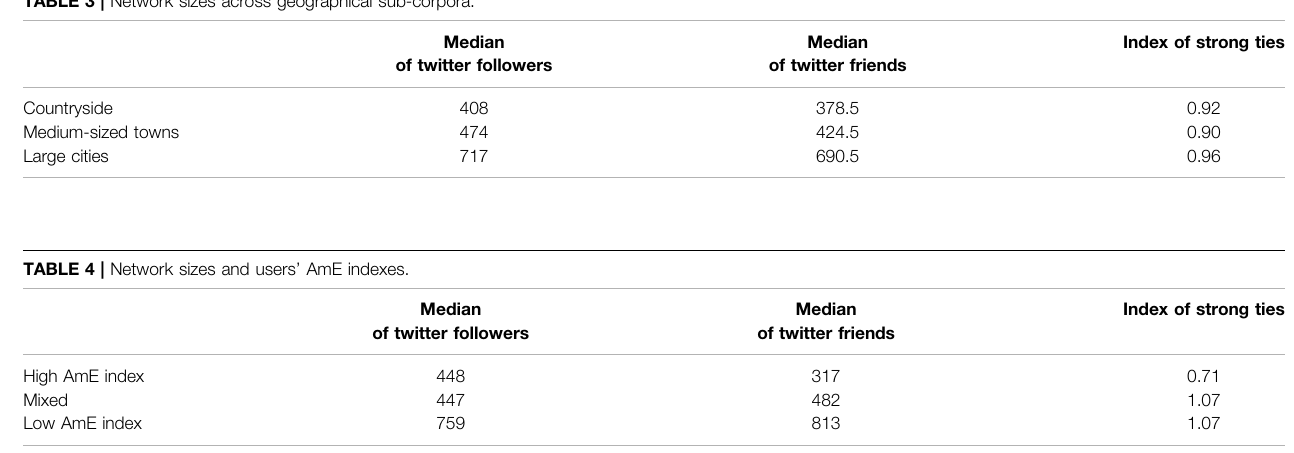
TABLE 3 | Network sizes across geographical sub-corpora.